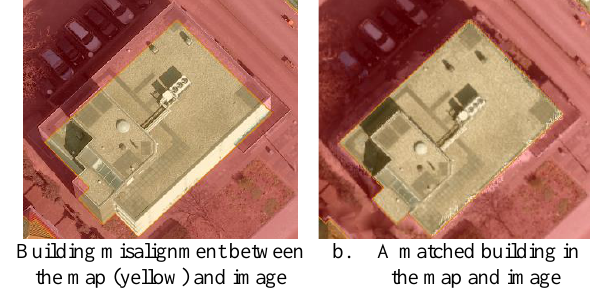
Figure 8. Removing the misalignment problem Figure 6. The 1-D Atrous convolution representation （ Liang et al., 2018) Figure 9., the pixels of the overhanging roof in the image (inside the blue ellipse of Figure 9.a.) are detected and then assigned as zero value with black color (inside the blue ellipse of Figure 9.b.).